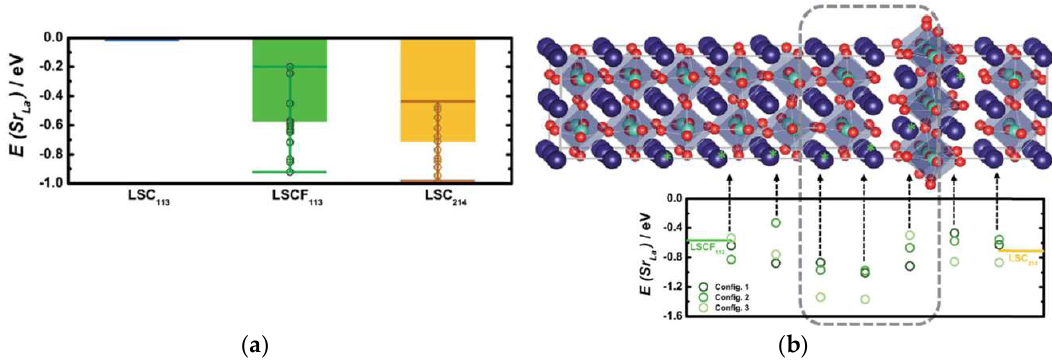
Figure 10. ( a ) The calculated Sr/La substitution energies in the bulk LSC 214 , LSC 113 , and LSCF 113 (all relative to that of LSC 113 , which is set to 0). ( b ) The heterostructured interface model used in the DFT simulations and the results of Sr/La substitution energies. The elements are represented as: La/Sr (dark blue), Fe/Co (light blue, center of the octahedra), and O (red). Reprinted from [86] with permission of The Royal Society of Chemistry.